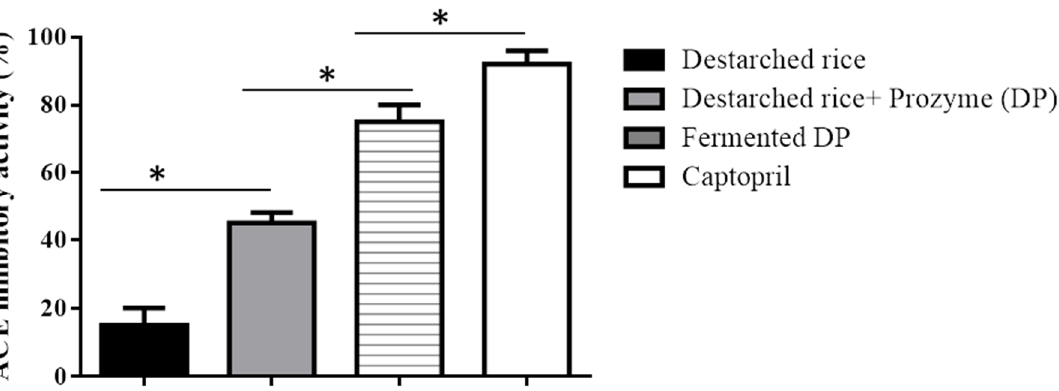
Figure 1. ACE inhibitory activities of destarched rice, Prozyme treated destarched rice (DP), and fermented DP. Data show mean SD ( n = 3). Each bar represents the means of three replicates ± S.D. * denotes a significant difference between the ACE inhibitory ability of the samples.